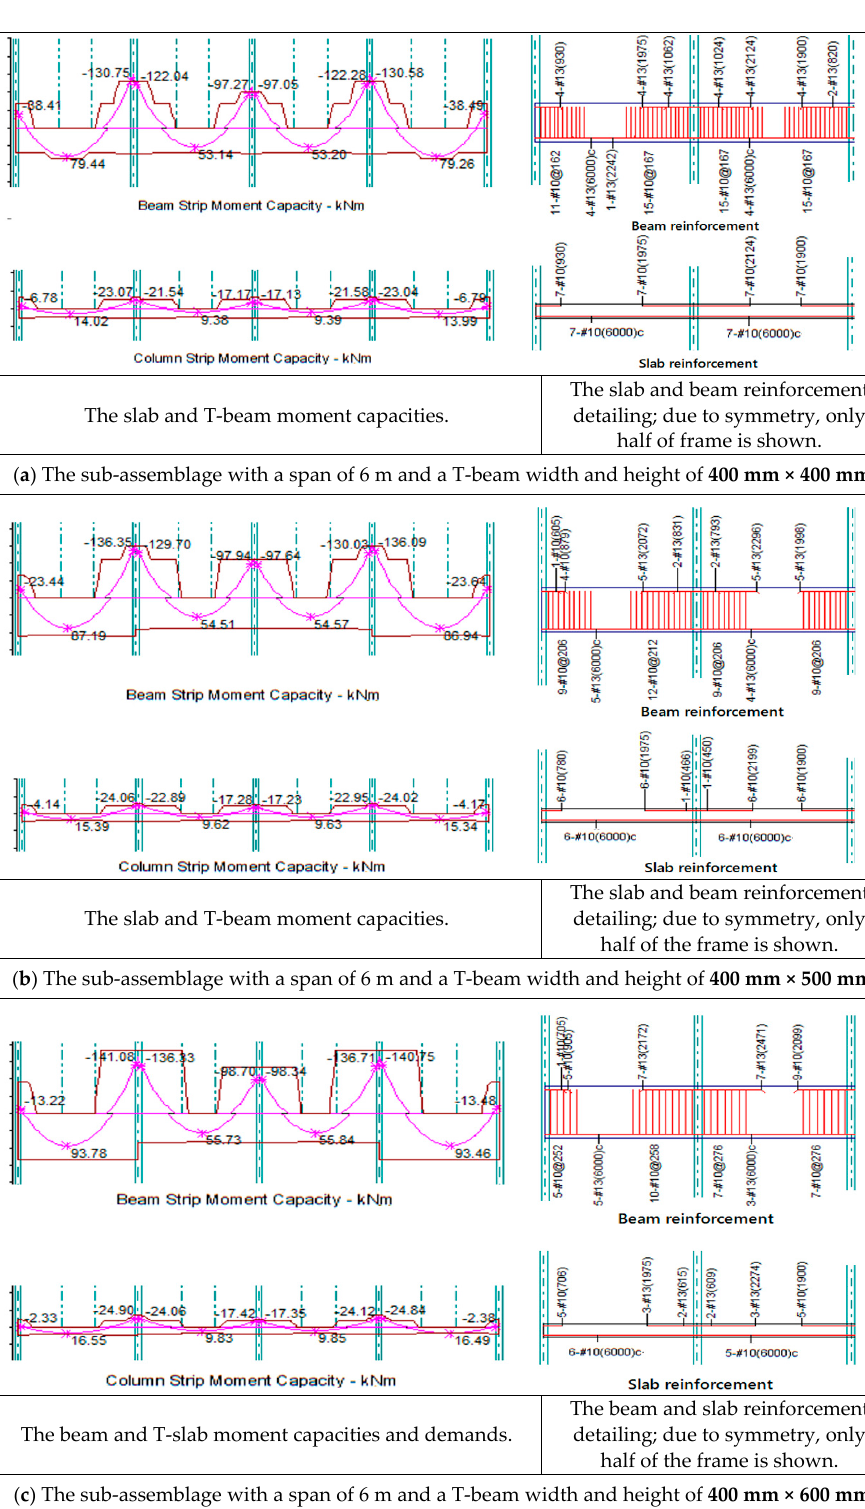
Figure 2. Samples of the spSlab/spBeam analysis and its design outcomes.